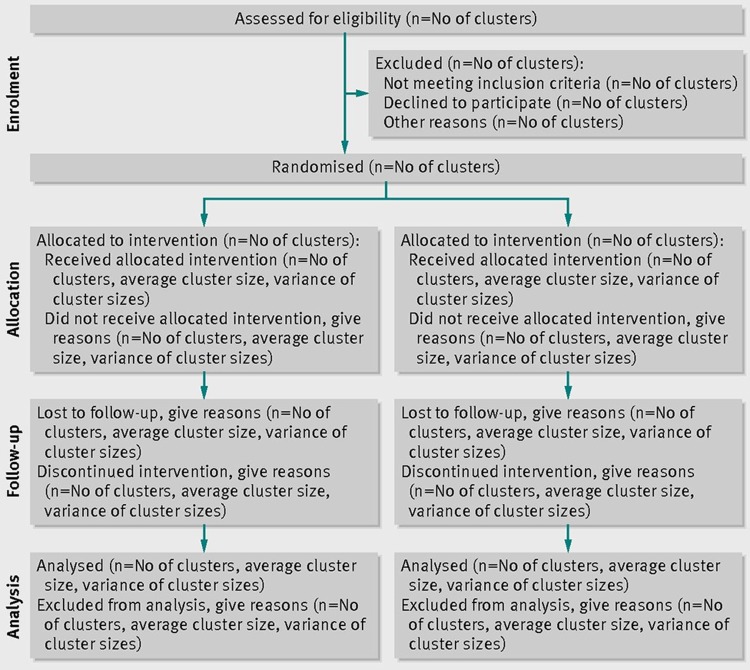
CONSORT flow chart.